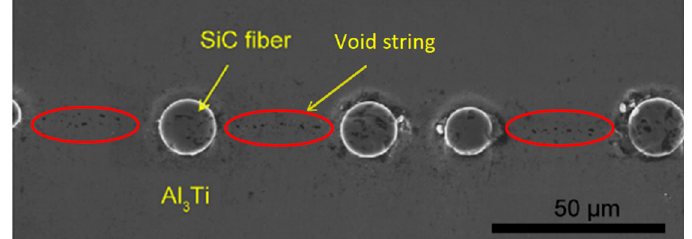
Figure 24. SEM image of SiC fibers in Ti-(SiC f /Al 3 Ti) composite showing the microstructure of void strings along the center line of SiC fiber string between adjacent fibers.